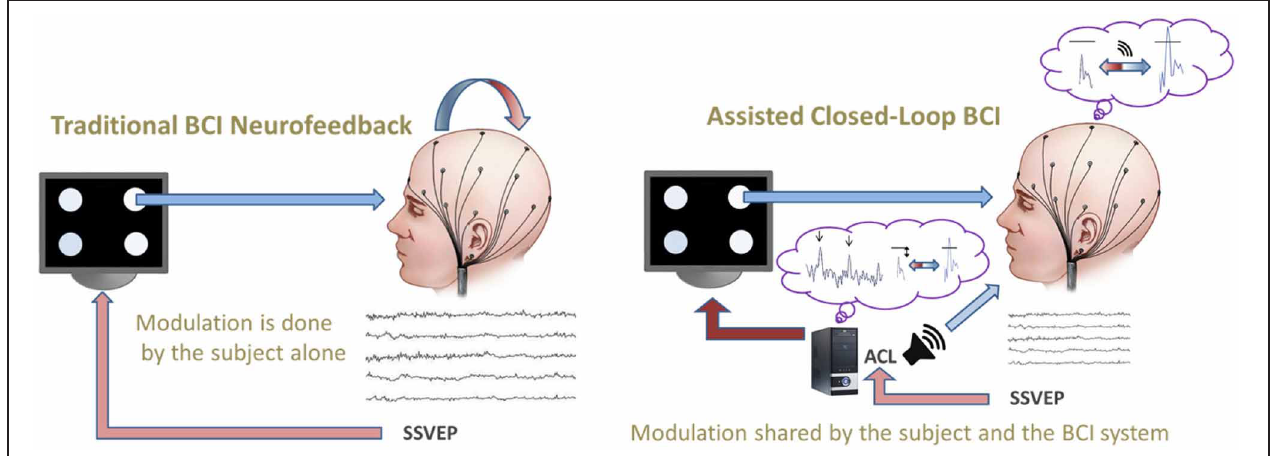
assisted closed-loop provides online information (i) to the system about the most effective flicker frequencies and (ii) to the subject about the actual distance to the pre-defined threshold by continuous auditory feedback (loudspeaker symbol,